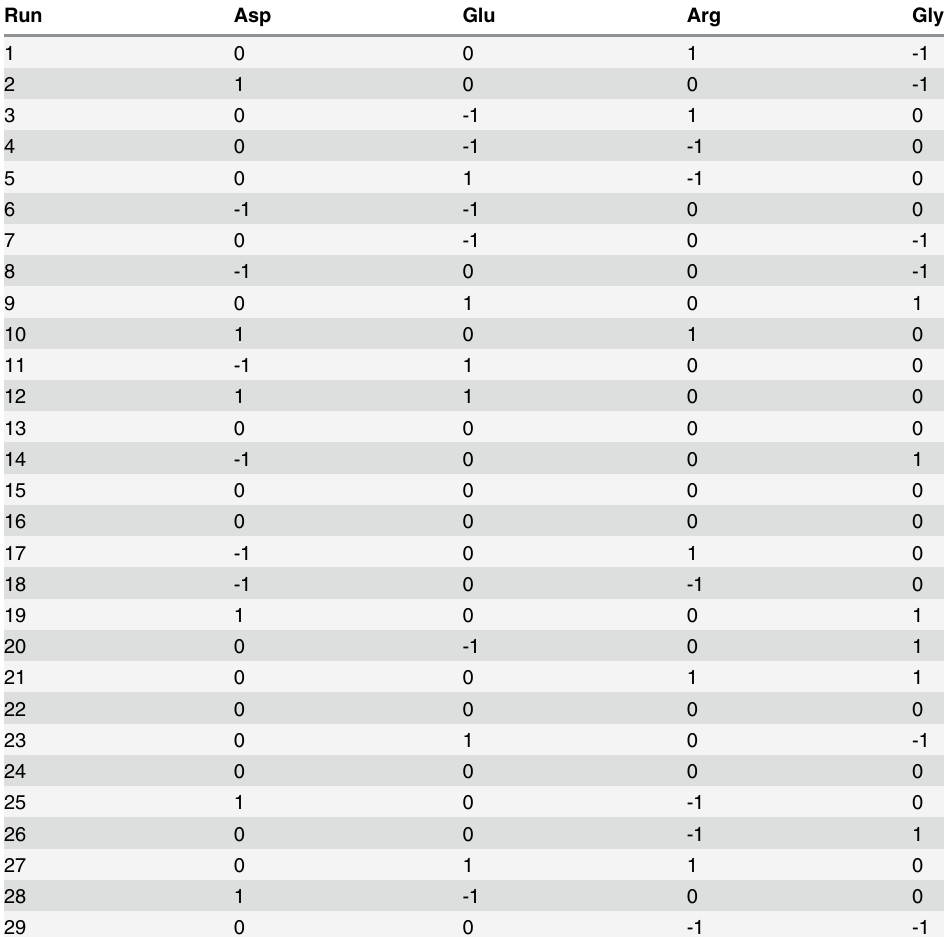
Table 2. Box-Bencken design matrix, the low level used in the design ( – 1) was the same as the higher level used in the Plackett-Burman design. The middle and high levels (0 and +1) were respectively 25% and 50% higher than the low